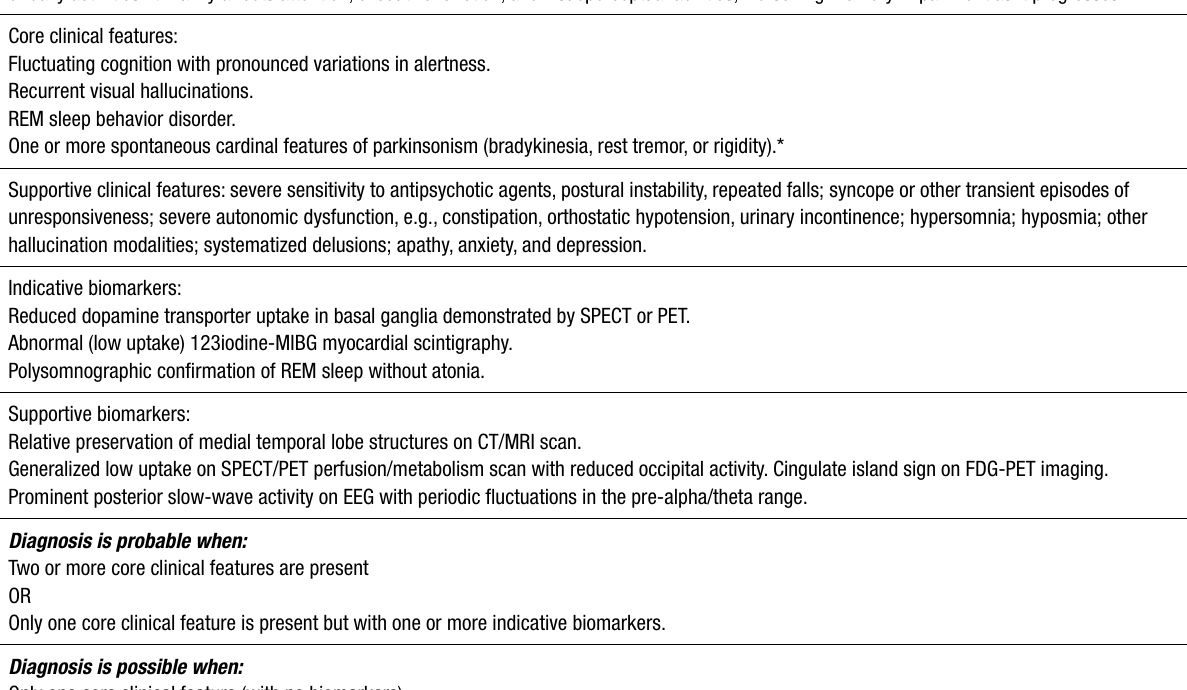
Table 2. Criteria for the diagnosis of probable and possible dementia with Lewy bodies 2 . 1. Essential: dementia is required for a diagnosis of DLB and defined as a progressive cognitive decline which affects social and occupational functions or daily activities. It mainly affects attention, executive function, and visuoperceptual abilities, worsening memory impairment as it progresses. Core clinical